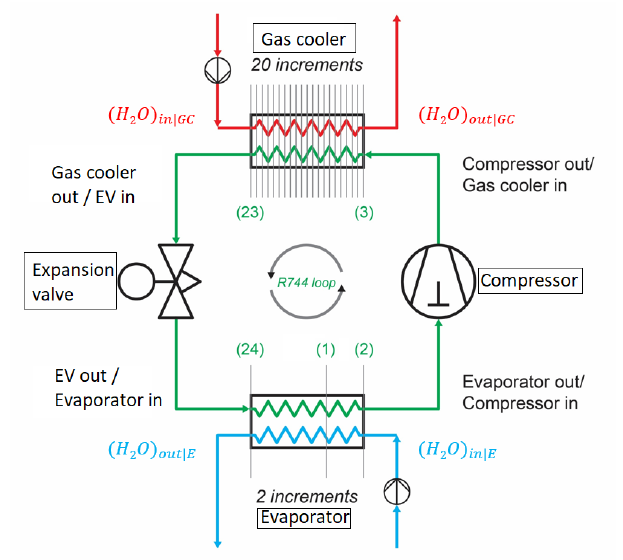
Figure 1. Illustration of the transcritical heat pump system with its cyclic points and components [22].